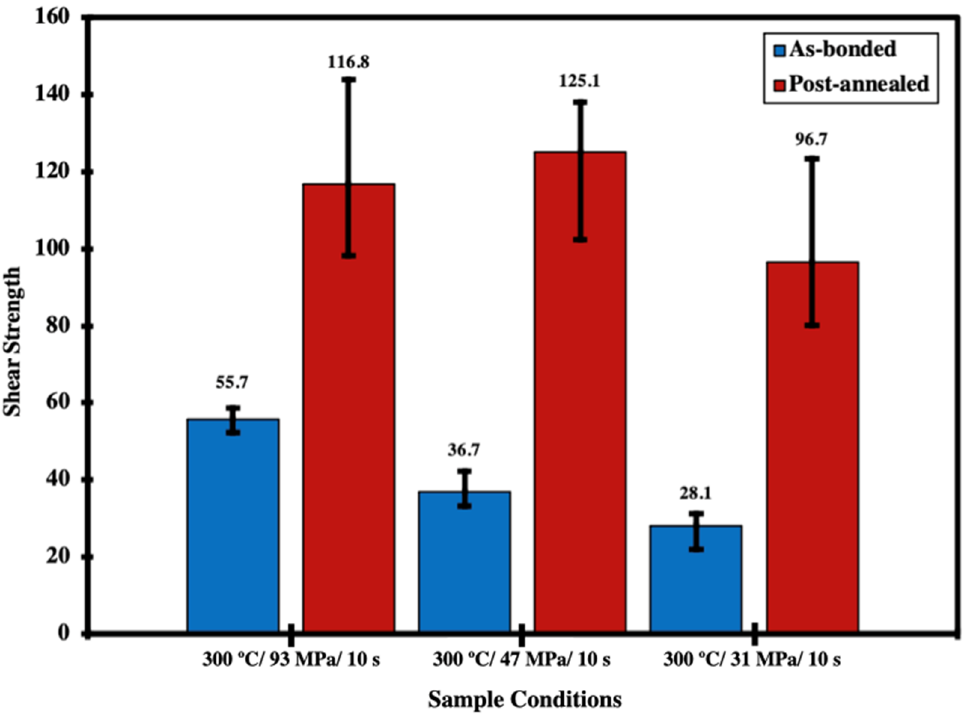
Figure 13. Shear strength of the as-bonded and post-annealed samples under various bonding conditions.